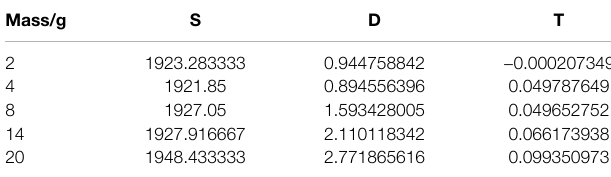
TABLE 6 | Measurement result of sample 1.